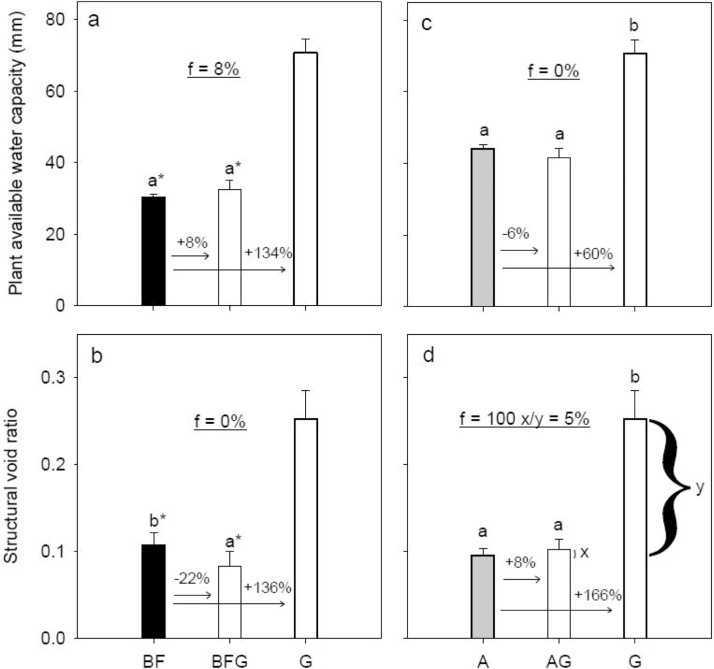
Restoration scenarios: Land use change effects on plant available water capacity calculated based on a soil mass equivalent to 20 cm in the G soil, and structural void ratio. White, gray and black bar fills represent grass, arable and bare fallow treatments, respectively, at time of sampling. Letters denote statistical significance at P < 0.05. An asterisk (*) indicates if G is significantly different from BF and BFG based on a pairwise t-test. The numbers above the arrows denote relative differences. The underlined number in the middle part of the figures denotes the rate of change, and was estimated by Eq. 9. An example of the calculation is shown in Fig. d. For treatment abbreviations, see Table 1.